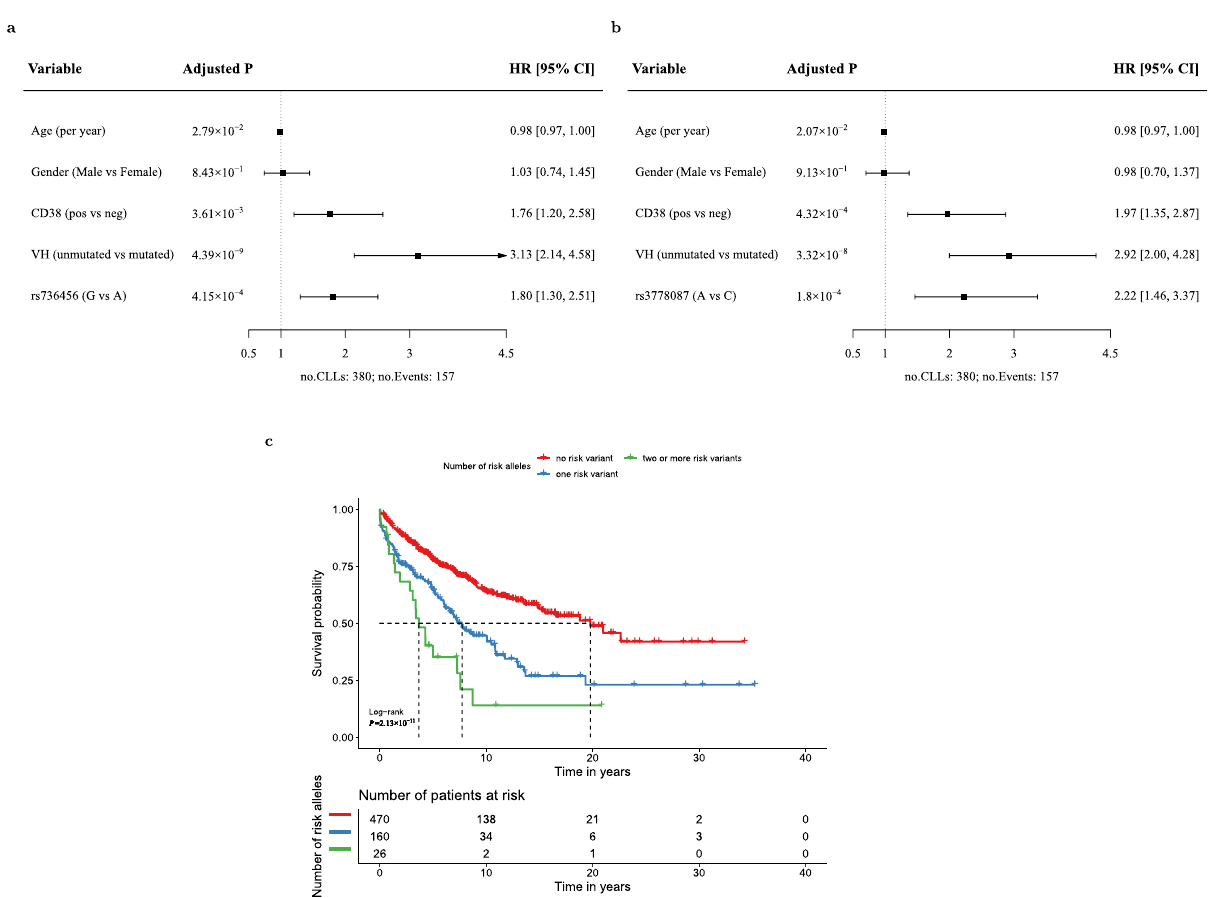
Fig. 4 Multivariate prognostication models for time to fi rst treatment (TTFT) and survival curves in Binet stage A CLL. Study-strati fi ed multivariable Cox proportional hazard model for TTFT in Binet A CLL patients incorporating rs736456 ( a ) and rs3778076 ( b ). Age at diagnosis (continuous), gender (binary), CD38 (binary), VH (binary) and SNP allelic dosage for the effect allele (continuous) were included together in a study-strati fi ed Cox proportional hazard model to estimate Hazard ratios (HR) and 95% con fi dence intervals (CI). CI and nominal P values from Wald tests based on the standard normal distribution were reported here. Cases with missing data for any of the variables were excluded from multivariate models. c Kaplan – Meier survival plot for TTFT by number of cumulative risk alleles (0, 1, >1) for rs3778076 and rs736456 in Binet A CLL patients. TTFT is de fi ned as the time from diagnosis of CLL to treatment or last follow-up without treatment. The number of patients in each group at each timepoint are indicated in the table. Nominal P value from the log-rank test is shown. All statistical tests were